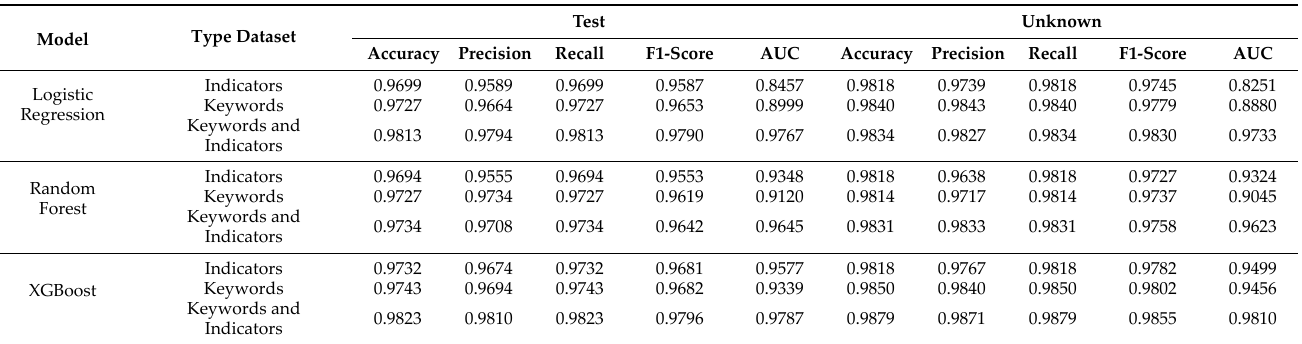
Table 7. Performance on